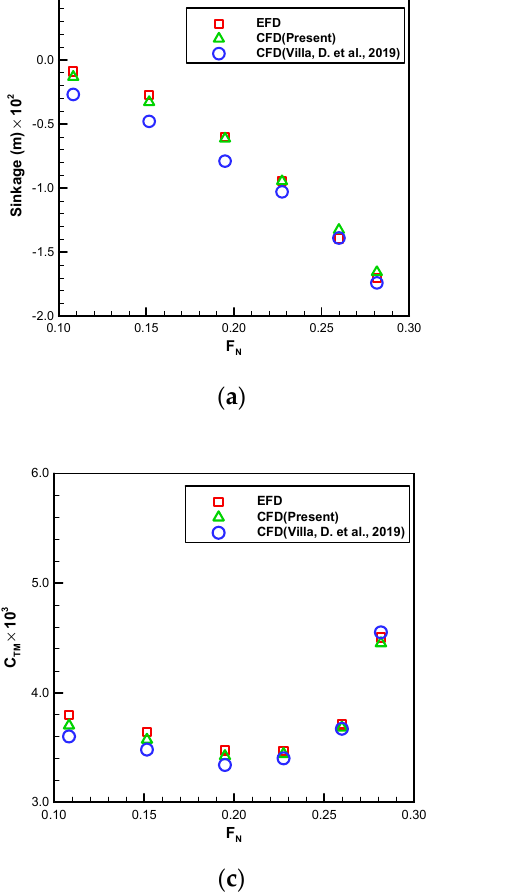
Figure 5. Comparison of KCS simulation results between EFD (Experimental Fluid Dynamics) and computational fluid dynamics (CFD) (a positive trim value was defined bow up and positive sinkage value was defined upward). ( a ) Sinkage; ( b ) trim; and ( c ) total resistance coefficient.